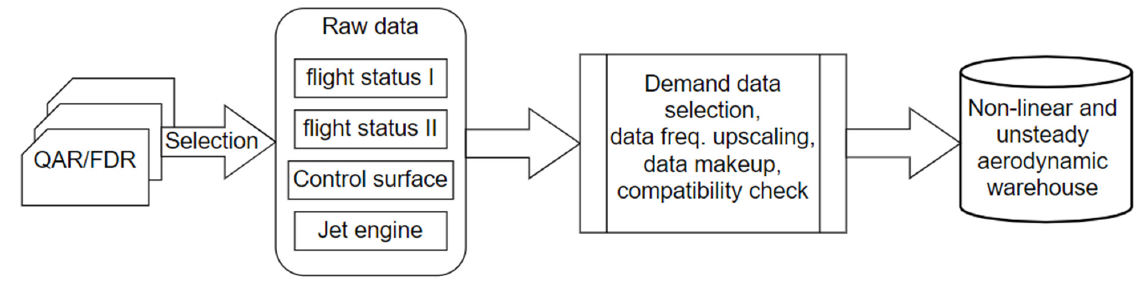
Figure 1. Flowchart for the development of a nonlinear and unsteady aerodynamic data database.